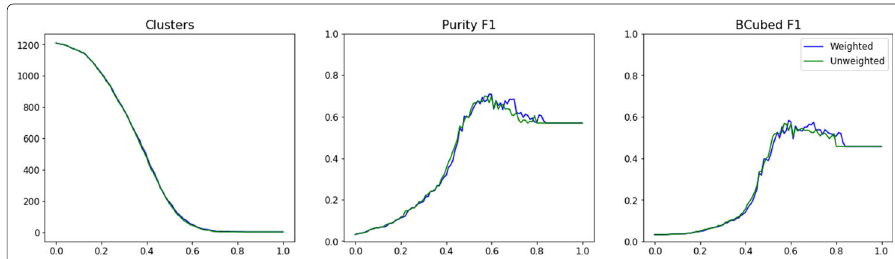
Fig. 8 Semantic role induction results according to the weighting of the edges. The horizontal axes refer to the neighboring threshold used to create the edges